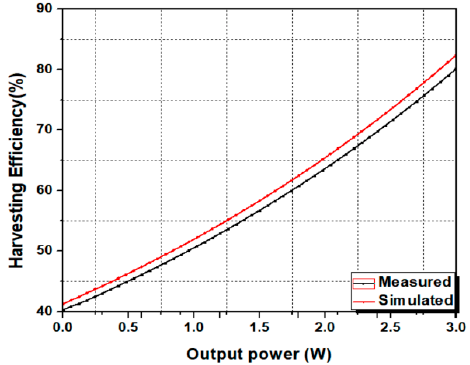
Figure 7. Variation of efficiency with respect to output power.